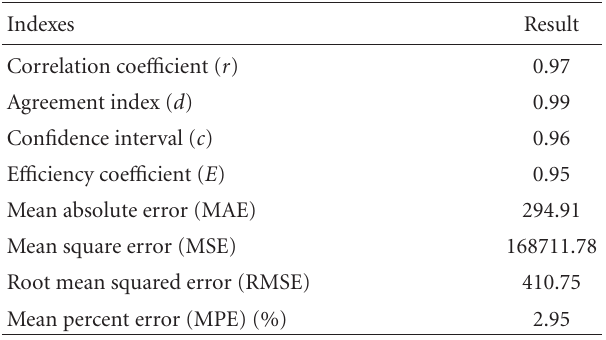
Table 2: Summary of the descriptive statistical analysis of erosivity values estimated by Silva et al. [8] and with the use of ANN in the Ribeira Valley and Coastal region of the State of S˜ao Paulo.